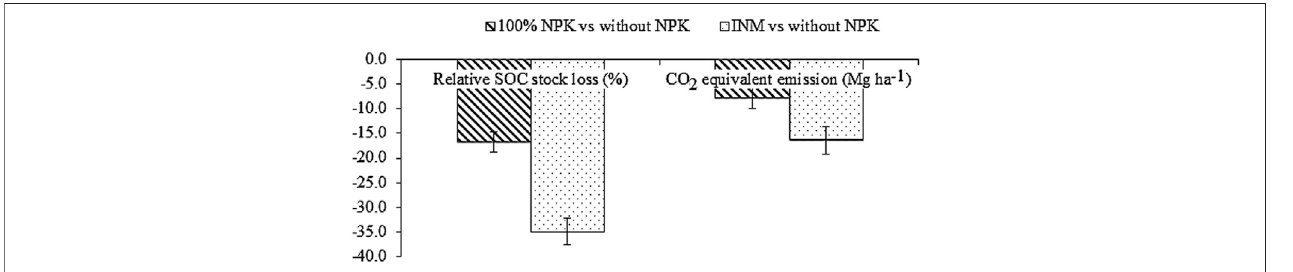
Frontiers in Environmental Science |